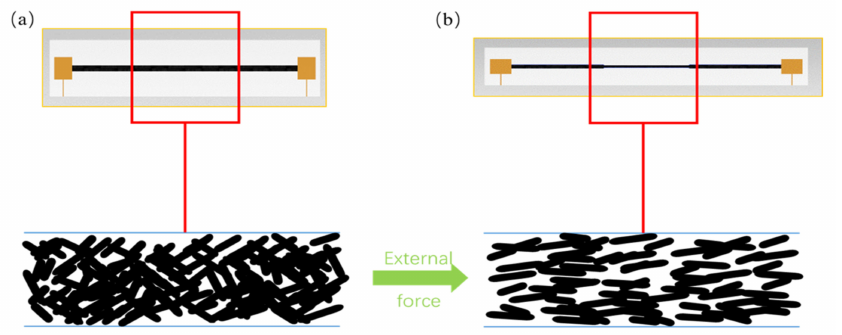
Figure 10. Microscopic mechanism of the developed flexible resistive sensor: ( a ) before applying the force; ( b ) after applying the